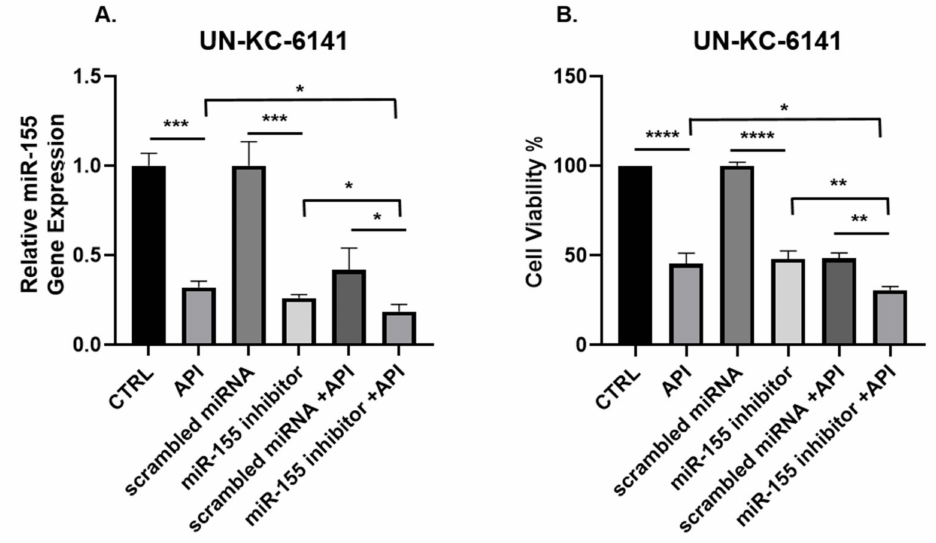
Figure 3. miR-155 gene expression and cell viability are synergistically suppressed in murine UN- KC-6141 cells after combined treatment with API and miR-155 inhibitor. UN-KC-6141 cells were treated with miR-155 inhibitor (100 nM), API (40 µ M), their respective controls or in combination and assessed for ( A ) miR-155 gene expression or ( B ) cell viability. Data are presented as the mean ± S.D. of each experimental group ( n = 3). * p < 0.05; ** p < 0.001; *** p < 0.001; **** p < 0.0001 (by two-tailed t